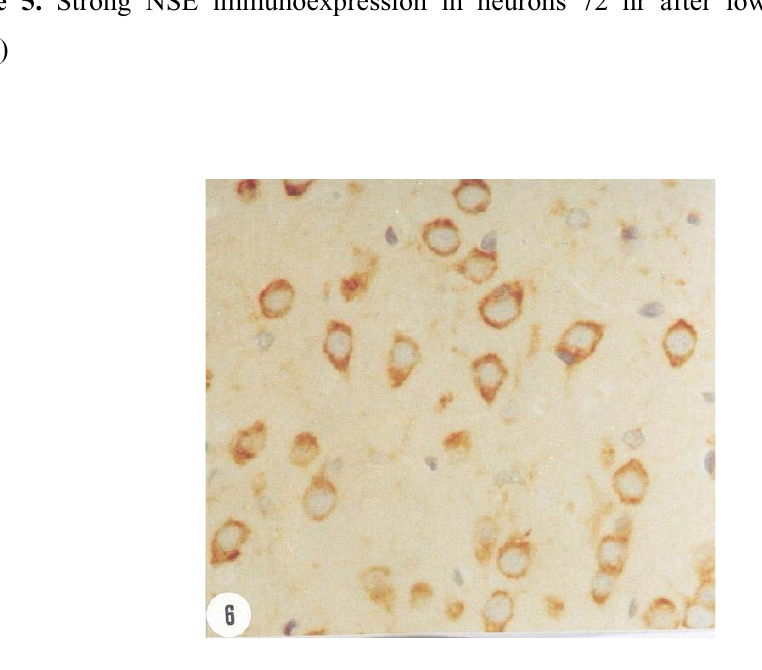
Figure 6. NSE immunoreactivity 24 hr after high dose envenoming.